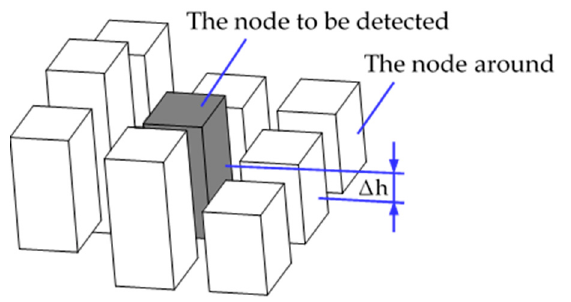
Figure 16. Schematic diagram to determine whether a node can pass through a certain area